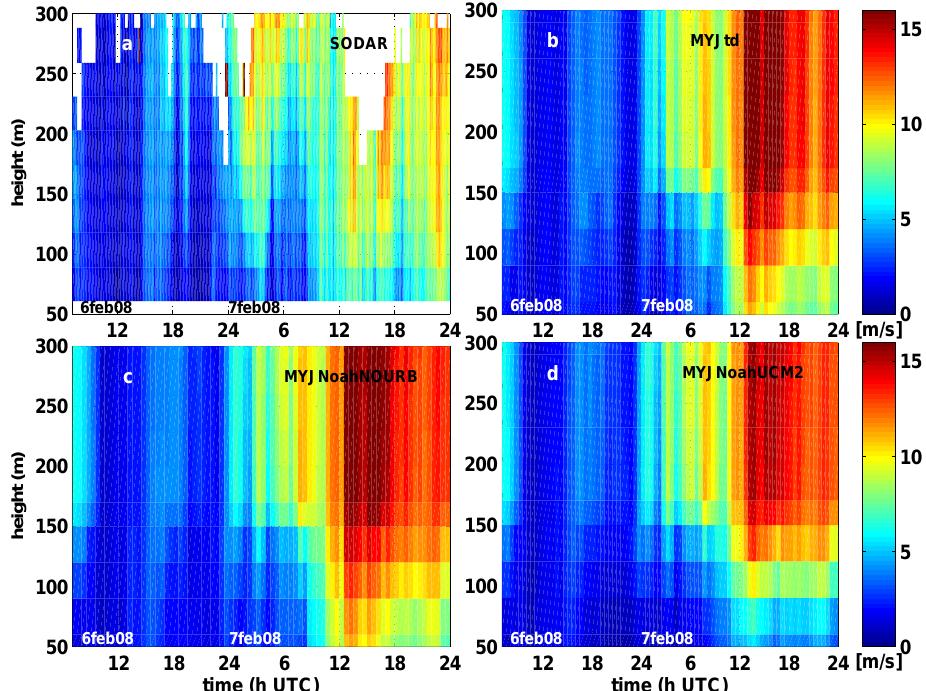
Fig. 9. Time series of the horizontal wind speed vertical profile on 6–7 February 2008 for (a) sodar measurements, (b) MYJtd, (c) MYJNoah- NOURB, (d) MYJNoahUCM2. Time is on the x axis and height on the ordinate axis.